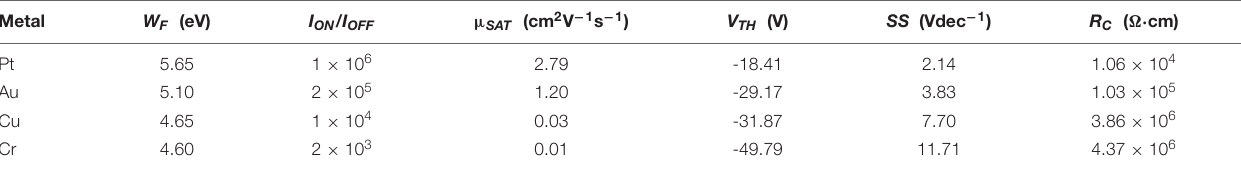
TABLE 1 | The key electrical parameters of IDT-BT OFETs with four different contact metals.